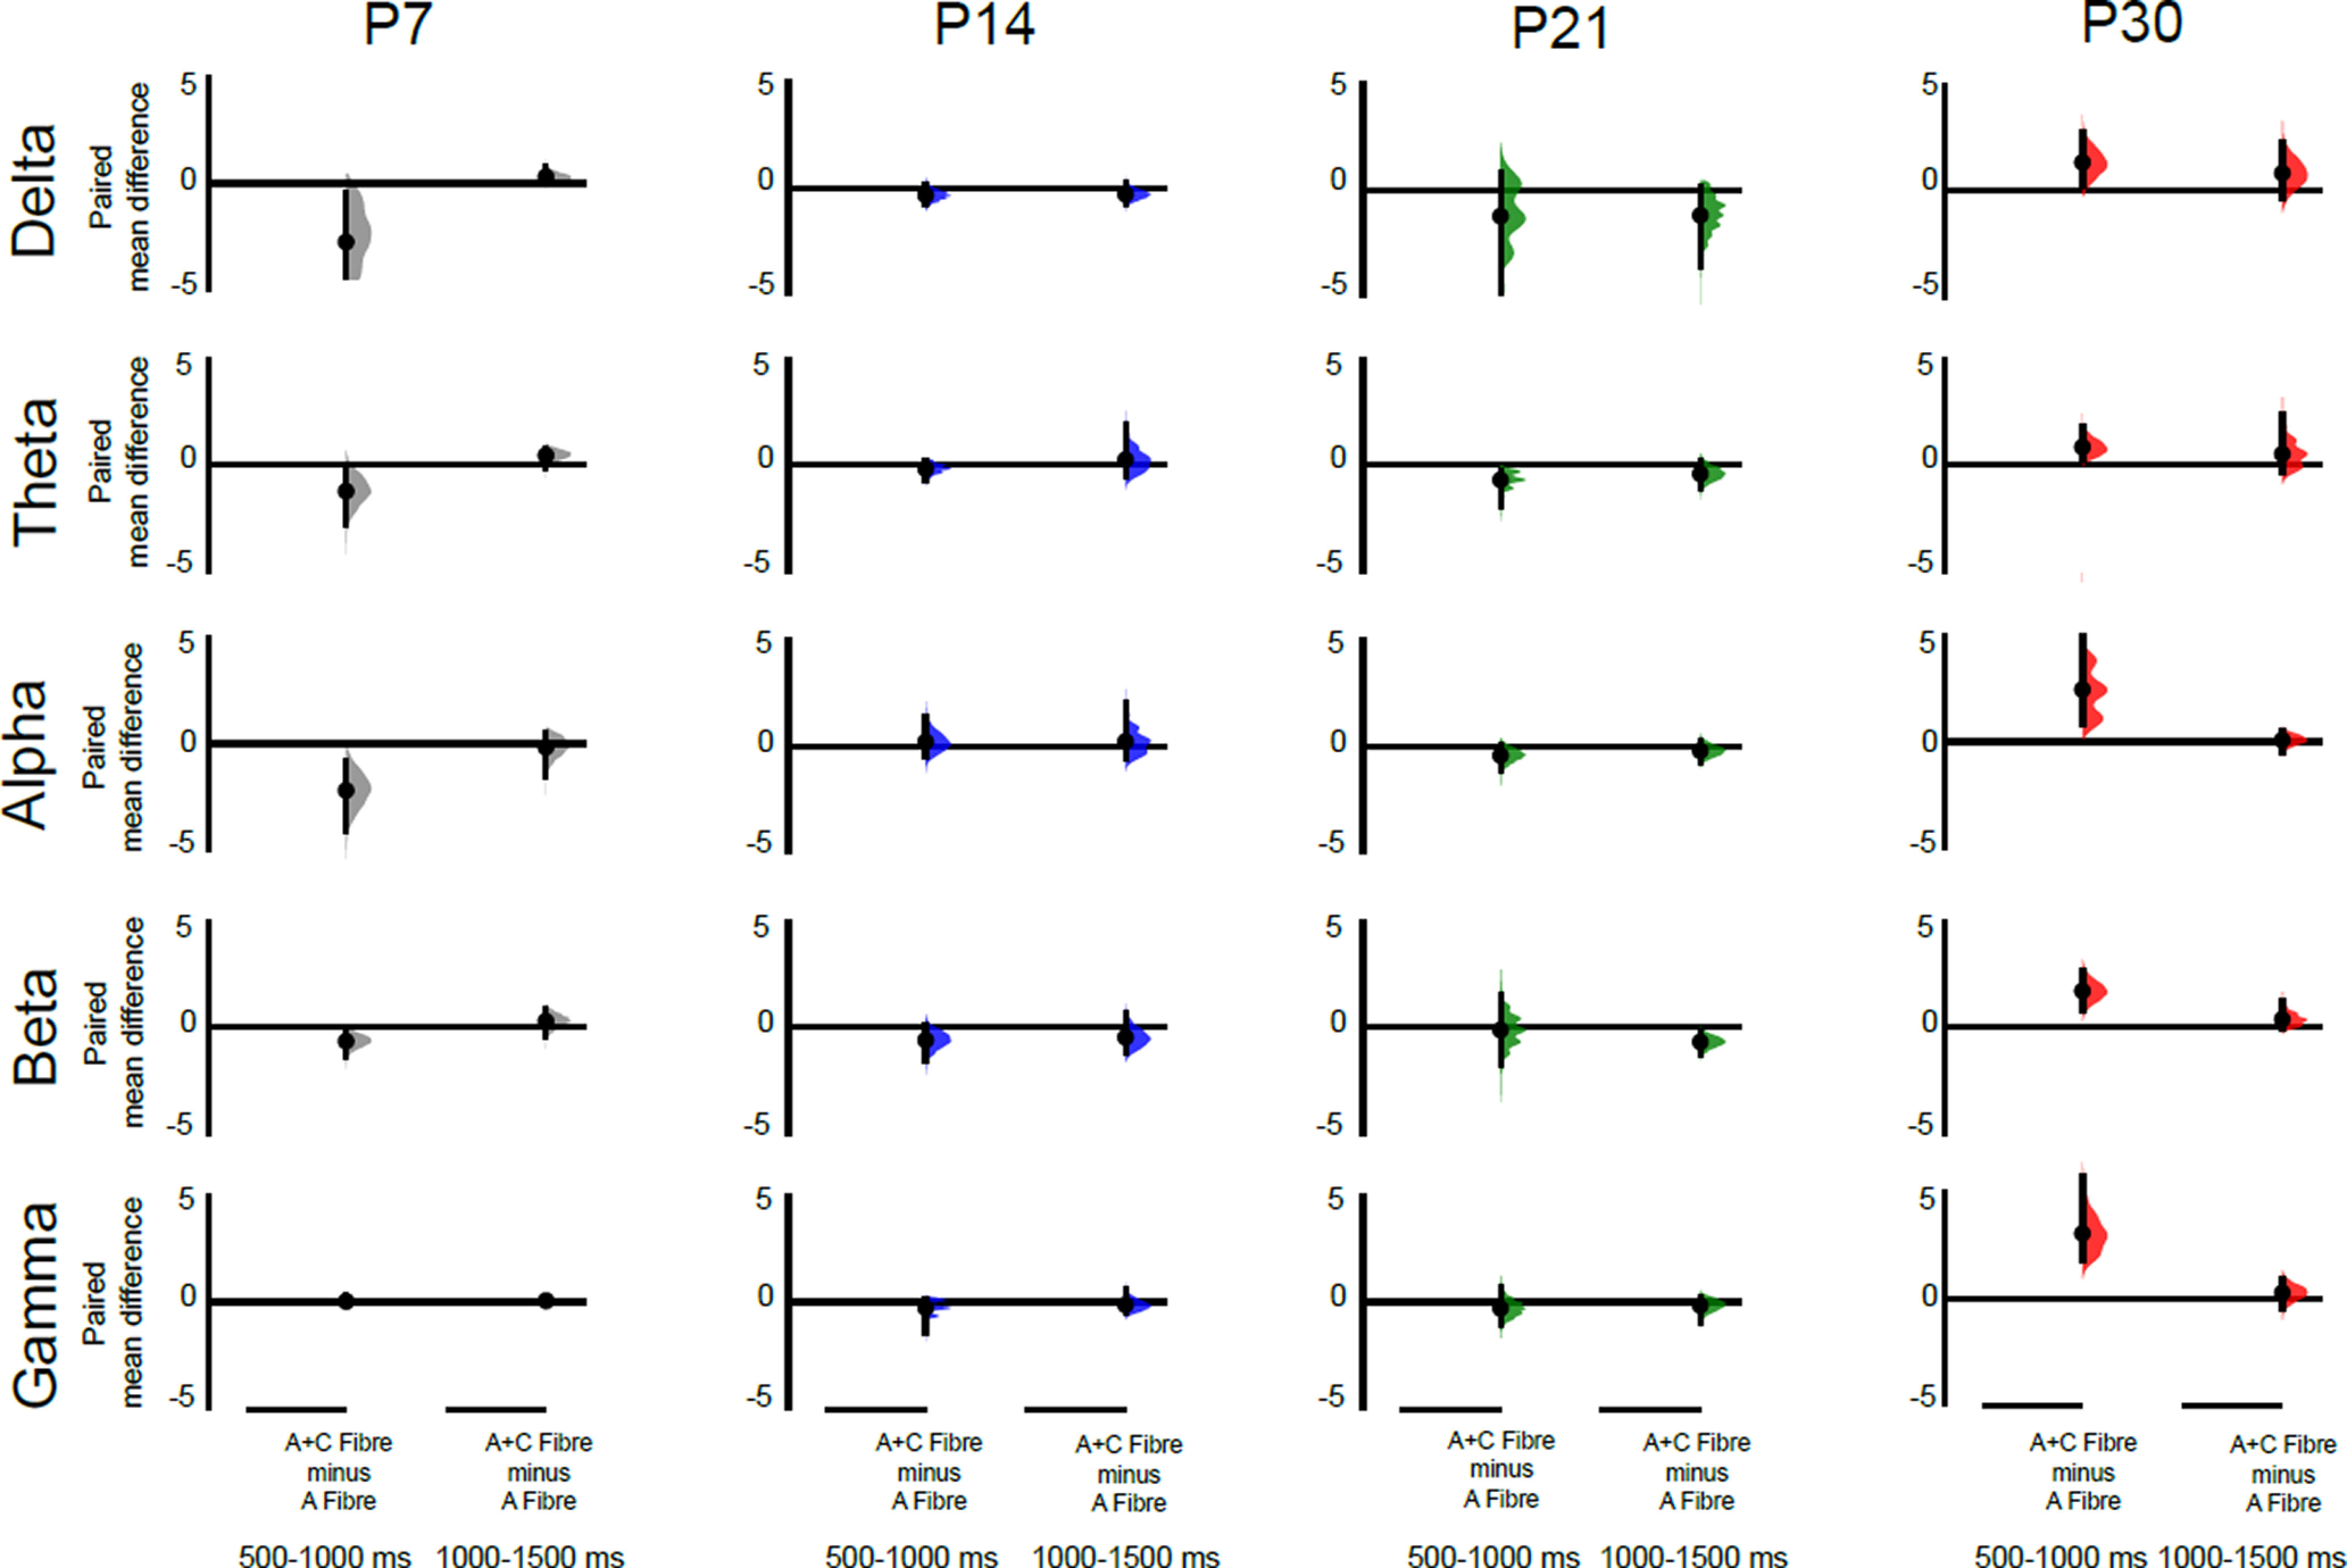
Recruitment of cutaneous C fibers evokes distinct age-related increases in S1 γ, β, and α oscillatory energy. Differences in the energy evoked by A + C fiber versus A fiber cutaneous stimulation in S1 at P7, P14, P21, and P30 (n = 6 animals per age). The paired mean difference at 500–1000 and 1000–1500 ms poststimulus are shown for each frequency band [δ (2–4 Hz), θ (5–7 Hz), α (8–12 Hz), β (15–29 Hz), and γ (30–90 Hz)]. Mean differences are depicted as dots; 95% confidence intervals are indicated by the ends of the vertical error bars. A positive value means indicates a greater energy following A + C fiber stimulation, compared with A fiber stimulation and can be attributed to recruitment of C fibers. Significant increases in γ, α, and β energy occur at P30, and a significant decrease in β energy occurs at P21. A shorter latency (0–500 ms) decrease in α energy at P7 is not shown. See text for effect sizes, confidence intervals, and permutation p values. Each paired mean difference is plotted as a bootstrap sampling distribution, using 5000 bootstrap samples, and the confidence intervals were bias corrected and accelerated (Ho et al., 2019).